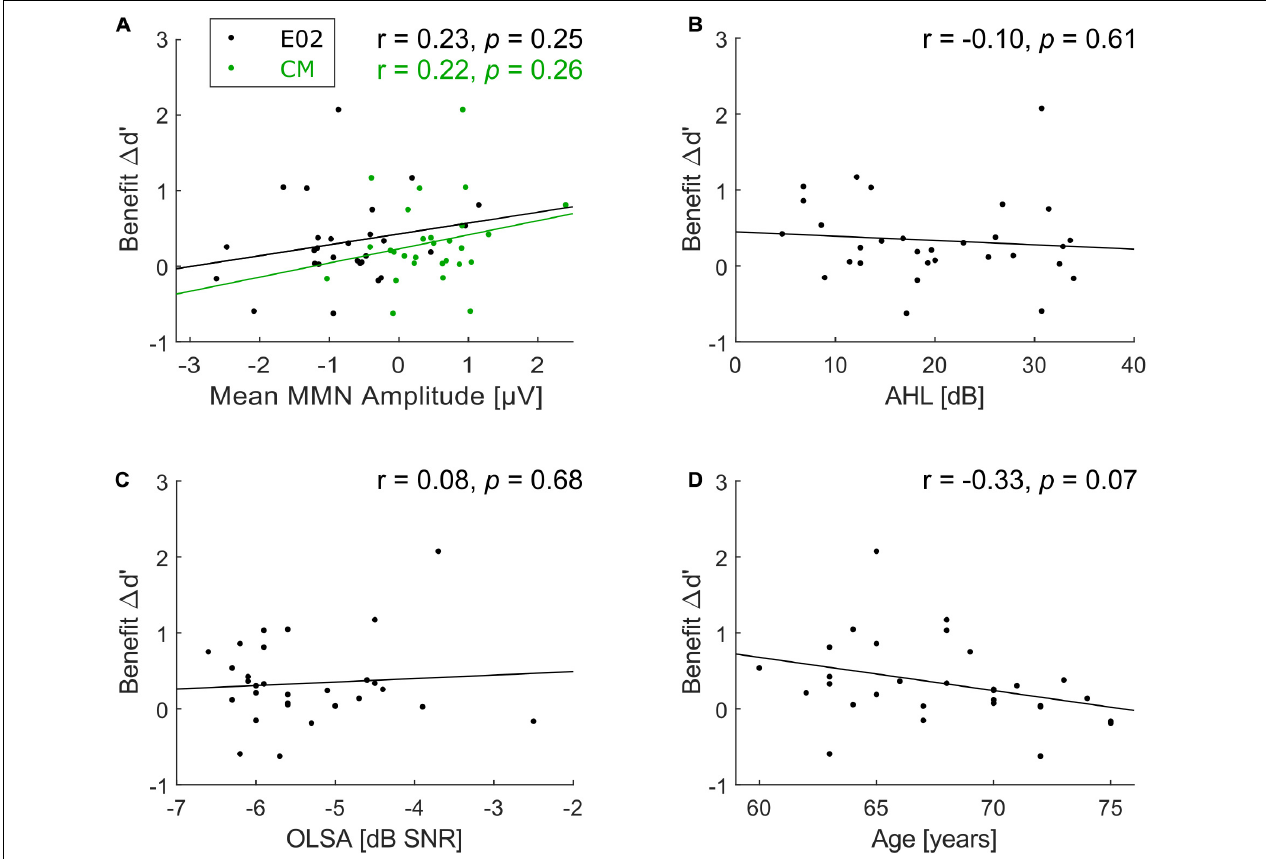
FIGURE 5 | Scatterplots of correlations with benefit. (A) Correlation between benefit (cid:49) d’ and mean MMN amplitude at frontocentral electrode position E02 (black dots) and common mastoids (CM, green dots; note that just 28 participants were included for both correlations), (B) between benefit (cid:49) d’ and average hearing loss (AHL), (C) between benefit (cid:49) d’ and speech-in-noise comprehension, and (D) between benefit (cid:49) d’ and age. No significant correlations with benefit (cid:49) d’ were found.